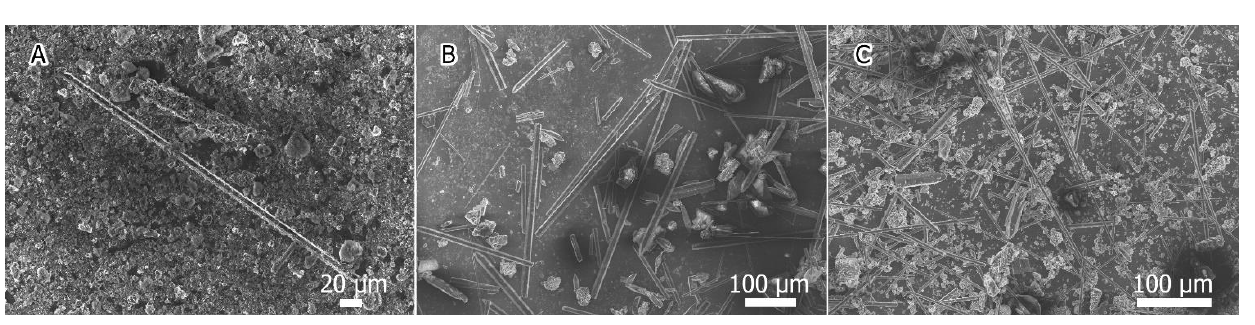
Figure 1. Microphotographs of three nc- Si samples with 20 at.% of sulfur, annealed at 850 °С for 1 ( A ), 3 ( B ) and 5 ( C ) h, respectively.